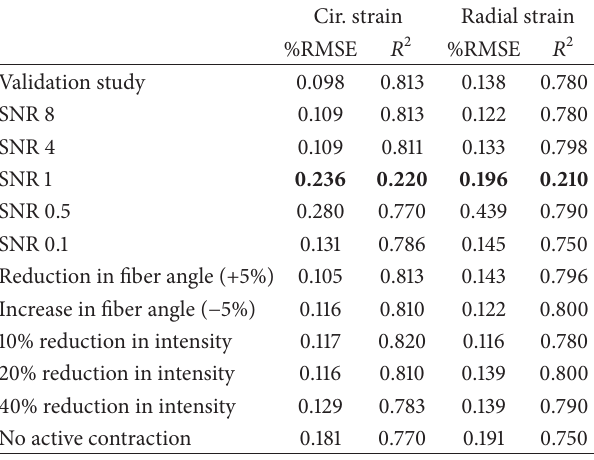
Table 1: Sensitivity results for Heart 1. The sensitivity study results for the Heart 1 analyses indicate that warping was relatively insensitive to image noise, moderate decreases in image intensity, and changes in fiber orientation. An SNR level of 1 (bold) caused severe degradation of the registration results with large increases in %RMSE and a reduction of the 𝑅 2 values. The lack of active contraction in the analysis also resulted in degradation of the error measures.